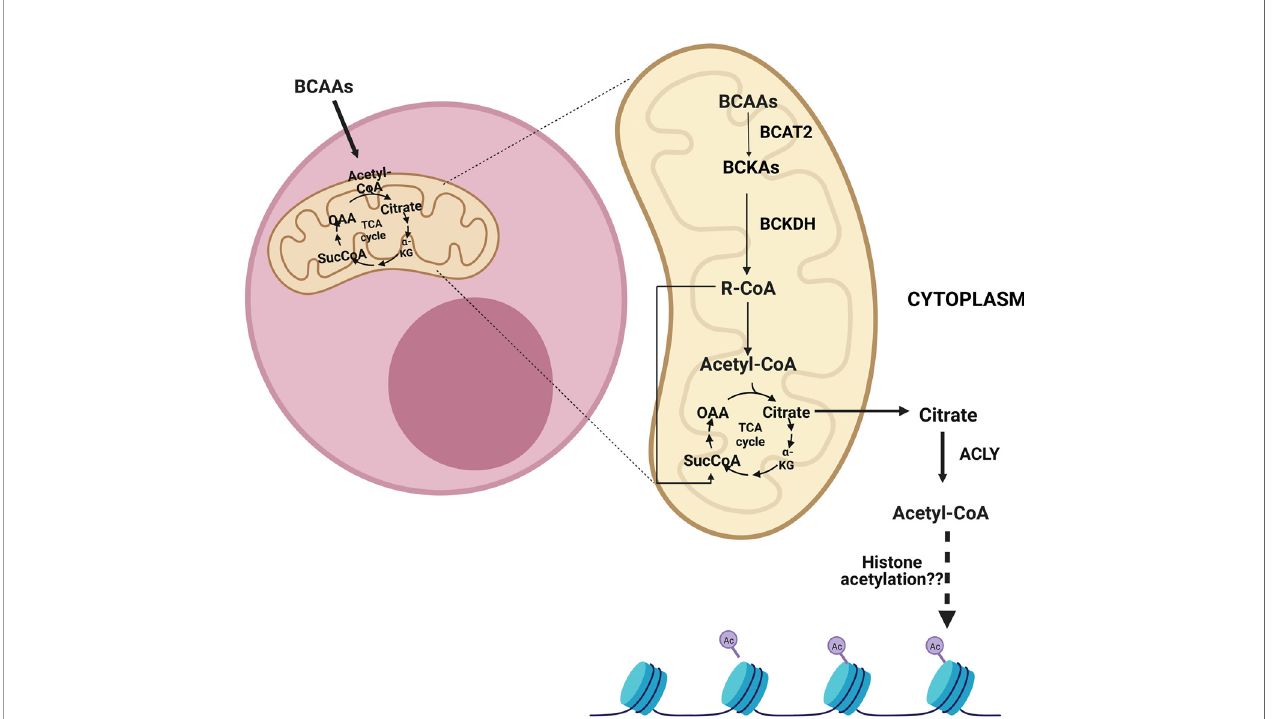
FIGURE 3 | After the entry of branched-chain amino acids (BCAAs) into cells, they can be catabolized in the mitochondria into acetyl-CoA and/or succinyl-CoA depending on which BCAAs enter the reaction. Following entry into the mitochondria, BCAAs go through a transamination reaction by the branched-chain amino acid transaminase 2 (BCAT2) and become branched-chain keto acids (BCKAs). Then, the branched-chain a-keto acid dehydrogenase complex (BCKDH) forms branched-chain acyl-CoA (R-CoA) irreversibly. Subsequently, acetyl-CoA and/or succinyl-CoA can be formed as a result of several reactions. These metabolites can be transmitted to the tricarboxylic acid cycle (TCA), which also results in the formation of citrate. The citrate can be exported from mitochondria and can be converted to cytoplasmic acetyl-CoA by ATP citrate lyase (ACLY). ACLY may assume a role in sustaining cytoplasmic acetyl-CoA, which is implicated in histone